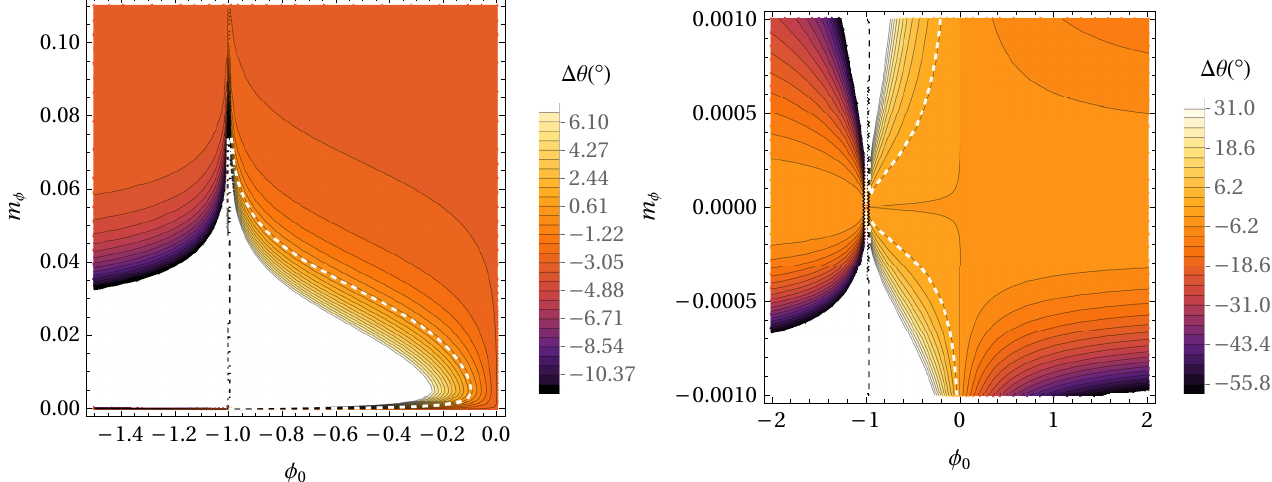
Figure 1. The precession per orbital period for the φ 0 - m φ parameter space in the case of the Hybrid Palatini gravity potential with extended mass distribution in the case of the S2 star. The mass density distribution of extended matter is ρ 0 = 2 × 10 8 M (cid:12) pc − 3 . With a decreasing value of the precession angle, the colors are darker. Parameter m φ is expressed in AU − 1 . The white dashed line depicts the locations in the parameter space where the precession angle has the same value as in GR (0 ◦ .18). The right panel represents the same as the left panel but for smaller values of the m φ parameter.